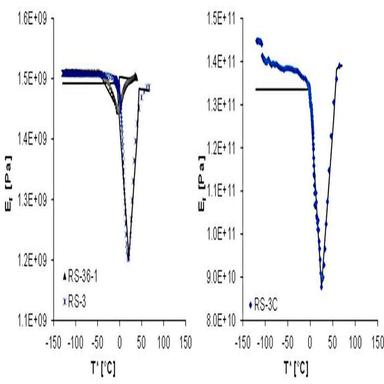
Evolution of the elastic resin modulus with respect to T with its model (solid line) for RS-36-1 and RS-3 (left), and RS-3C (right). (For interpretation of the references to colour in this figure legend, the reader is referred to the web version of this article.)